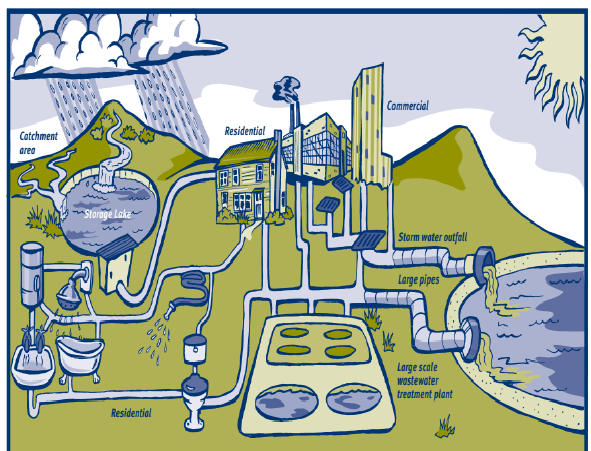
Figure 1. Leaner sanitation “end of pipe” (Ferguson et al., 2003).